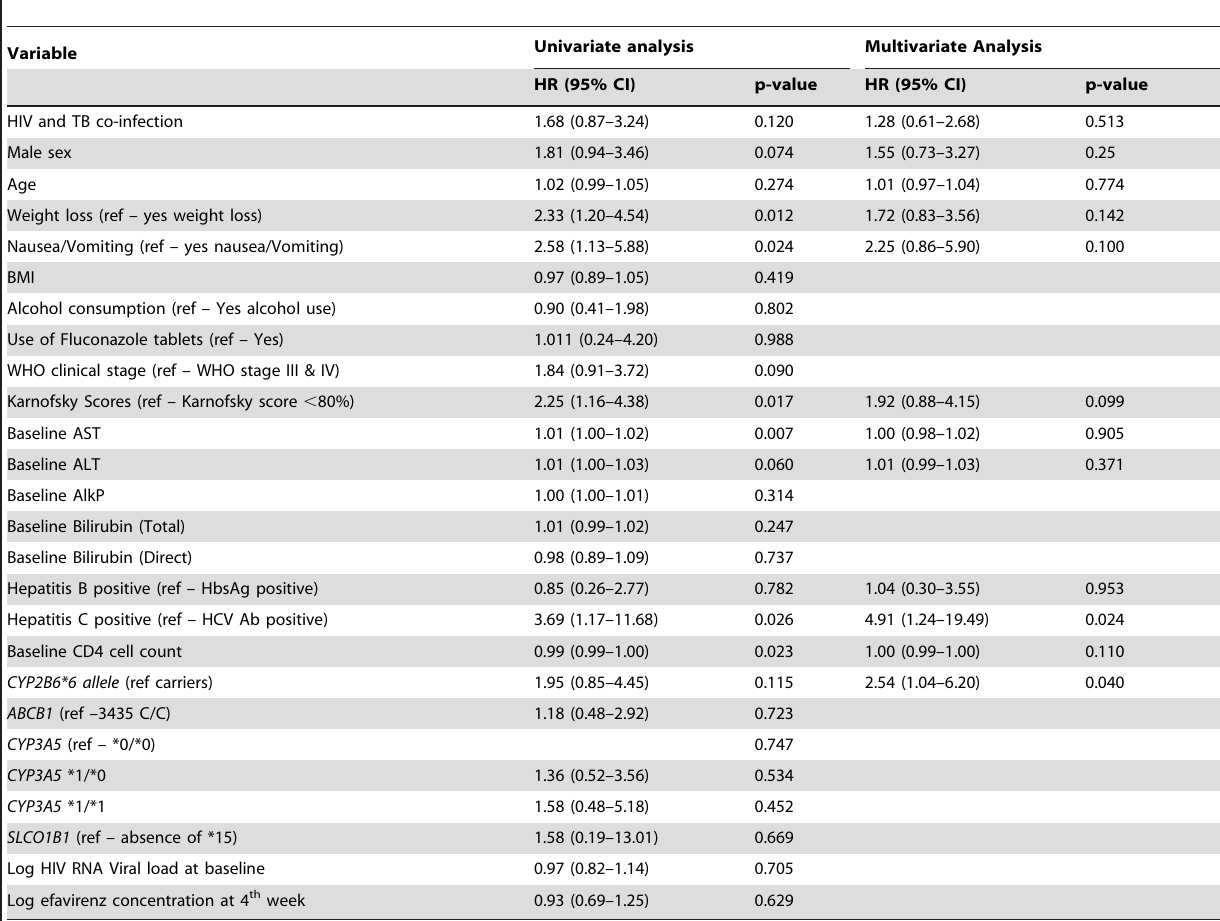
Table 3. Univariate and Multivariate Cox proportional regression analysis to show the risk factors for developing DILI.